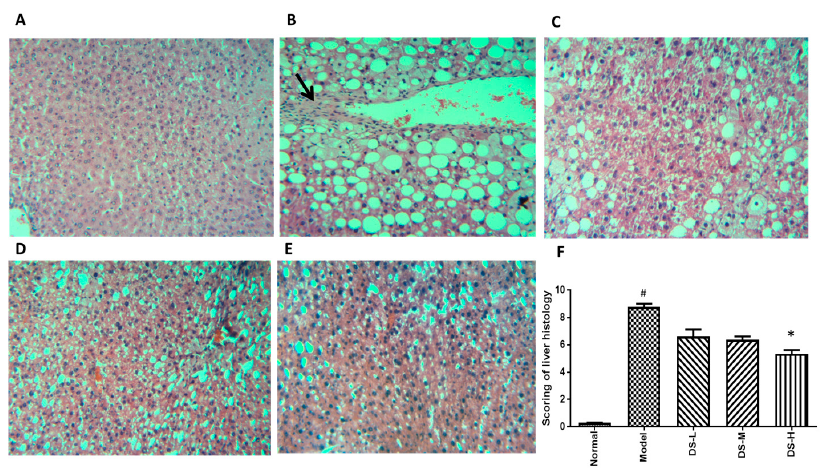
Figure 6. H&E staining results after Danshen treatment in NAFLD (original magnification 100 × ). Treatment with Danshen for six weeks attenuated the inflammation and macrovacuolar degeneration in NAFLD. ( A ) The normal group had a clear structure of the hepatic lobule, and there were no visible lesions; ( B ) In the model group, typical pathological characteristics such as inflammatory infiltration (black arrow) and macrovacuolar degeneration can be observed; ( C – E ) Treatment with Danshen (0.093, 0.28, 0.84 g/kg) for six weeks significantly attenuated the inflammation and macrovacuolar degeneration in the liver; ( F ) Scoring of liver histology of NAFLD mice with Danshen treatment (Mean ± SD). DS-L for low dose of Danshen treatment group (0.093 g/kg); DS-M for middle dose of Danshen treatment group (0.28 g/kg); DS-H for high dose of Danshen treatment group (0.84 g/kg). # p < 0.05, compared with normal group * p < 0.05 when compared with model group.